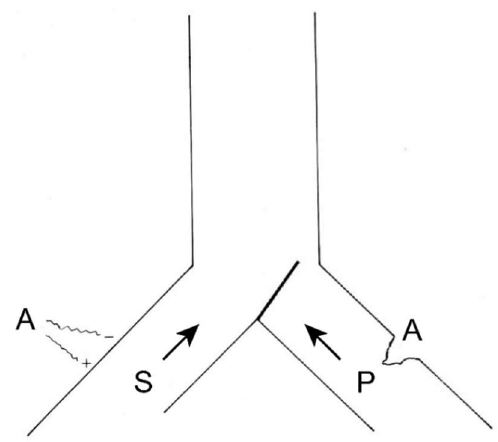
Figure 6. Therapeutic possibilities for reducing pain afferents. On the right, surgical interruption of pain pathways; on the left, increasing sensory afferents through neurostimulation. (see text).